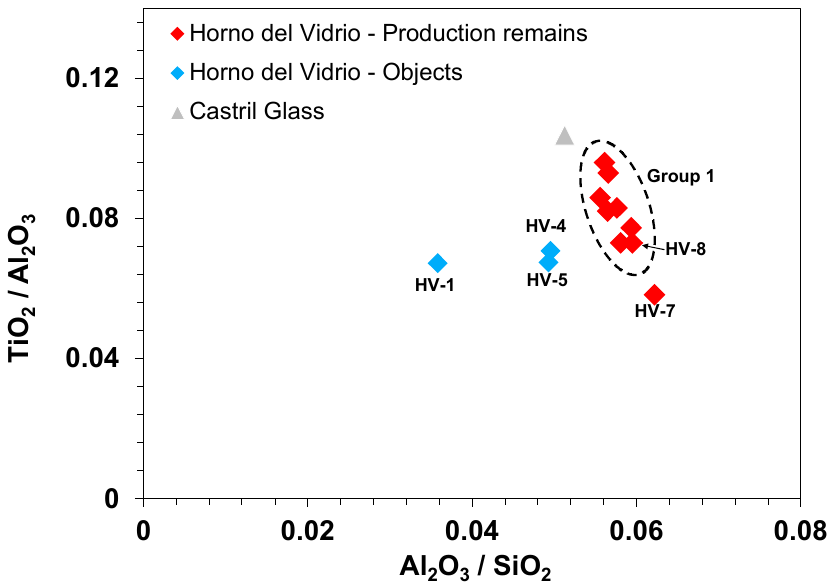
Figure 3. Binary plot of weight ratios of Al 2 O 3 /SiO 2 vs. the weight ratio of TiO 2 /Al 2 O 3 . The Castril Glass values were taken from [13].